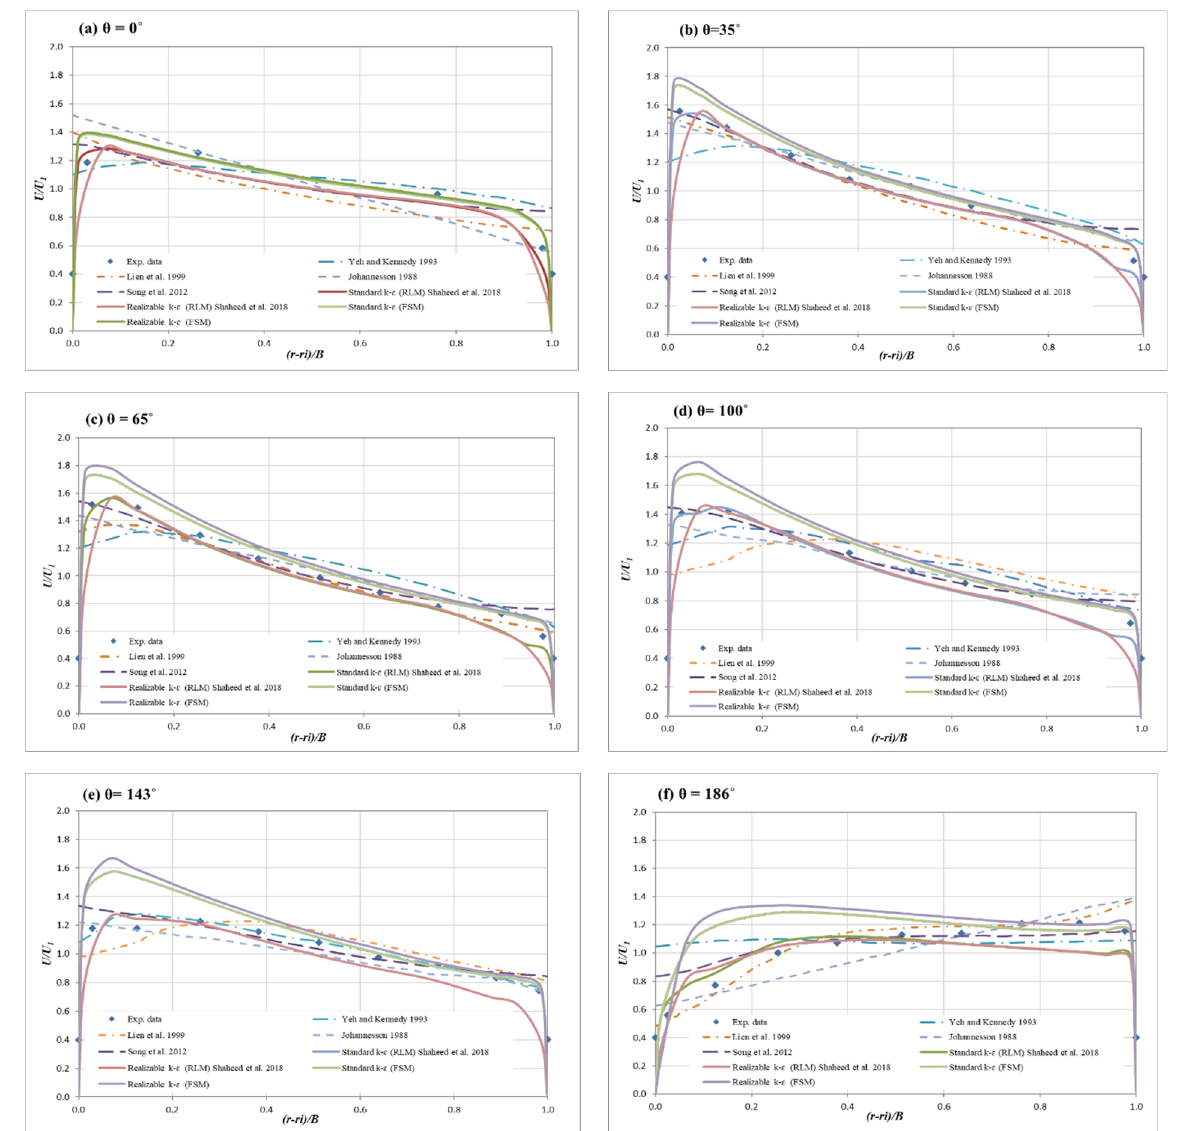
Figure 9. The resultant velocities comparison across the dimensionless channel width: ( a ) at θ = 0 ◦ ( b ) at θ = 35 ◦ ; ( c ) at θ = 65 ◦ ; ( d ) at θ = 100 ◦ ; ( e ) at θ = 143 ◦ ; and ( f ) at θ = 186 ◦ .